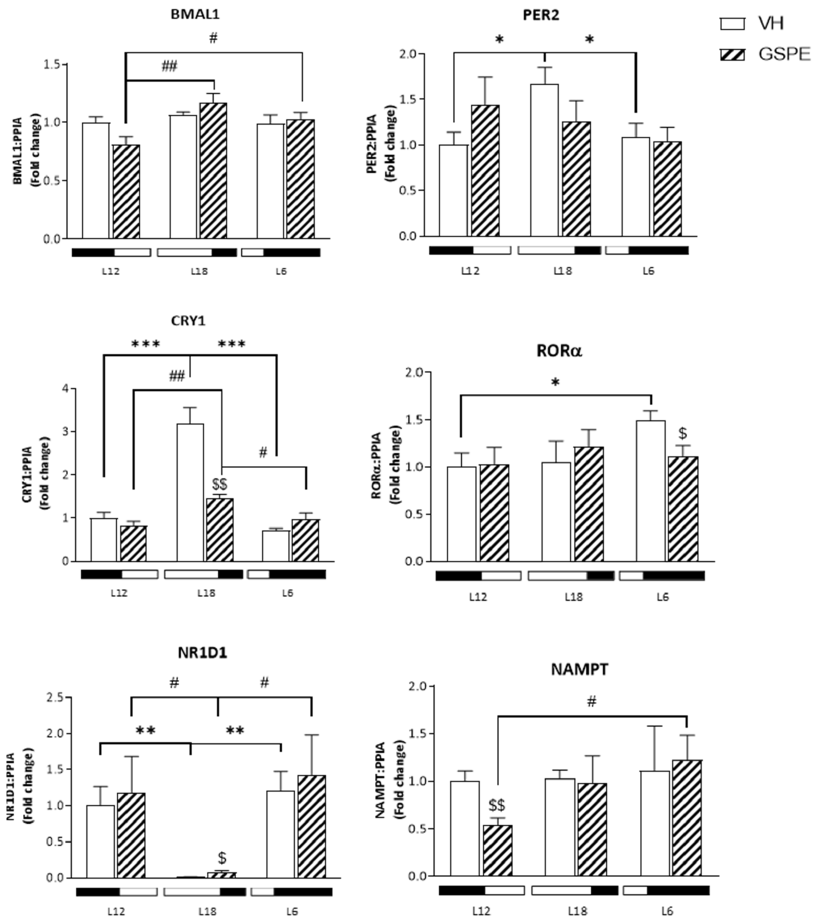
Figure 2. mRNA expression levels of clock genes in the liver of Fischer 344 rats treated with VH or GSPE exposed to standard (12 h light:12 h dark), long (18 h light:6 h dark), or short (6 h light:18 h dark) photoperiods fed with STD diet ( n = 8). The results are presented as the mean ± SEM. * indicates significant differences within VH groups (Student’s t test, * p < 0.05, ** p < 0.01, *** p < 0.001); # indicates significant differences within GSPE groups (Student’s t test, # p < 0.05, ## p < 0.01); $ indicates significant differences between treatments (VH vs. GSPE) (Student’s t test, $ p < 0.05, $$ p < 0.01). 3.4. Melatonin and Hormones from the Hypothalamus Pituitary Adrenal (HPA) Axes Have a Seasonal Variation which Is Affected by GSPE Consumption Serum levels of corticosterone, T3 and T4, together with melatonin were analyzed. In this sense, Figure 3 shows significant increase of corticosterone levels in L6-GSPE animals ( p = 0.01 vs. L6-VH, p = 0.004 vs. L12-GSPE, and p = 0.002 vs. L18-GSPE), whereas the L18 non-treated group shows an increase compared to the standard photoperiod ( p = 0.05). In the case of melatonin, GSPE raised the levels of this hormone in the L18 photoperiod ( p = 0,05); meanwhile, non-significant differences were found in T3 and T4 levels.